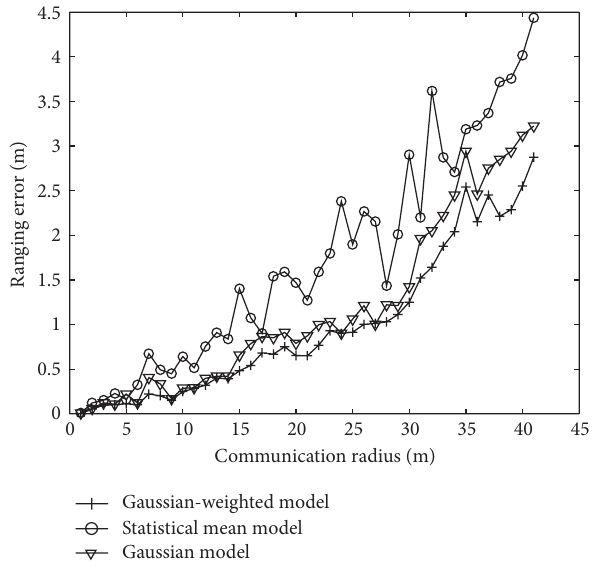
Figure 3: Comparison of the ranging error of RSSI.